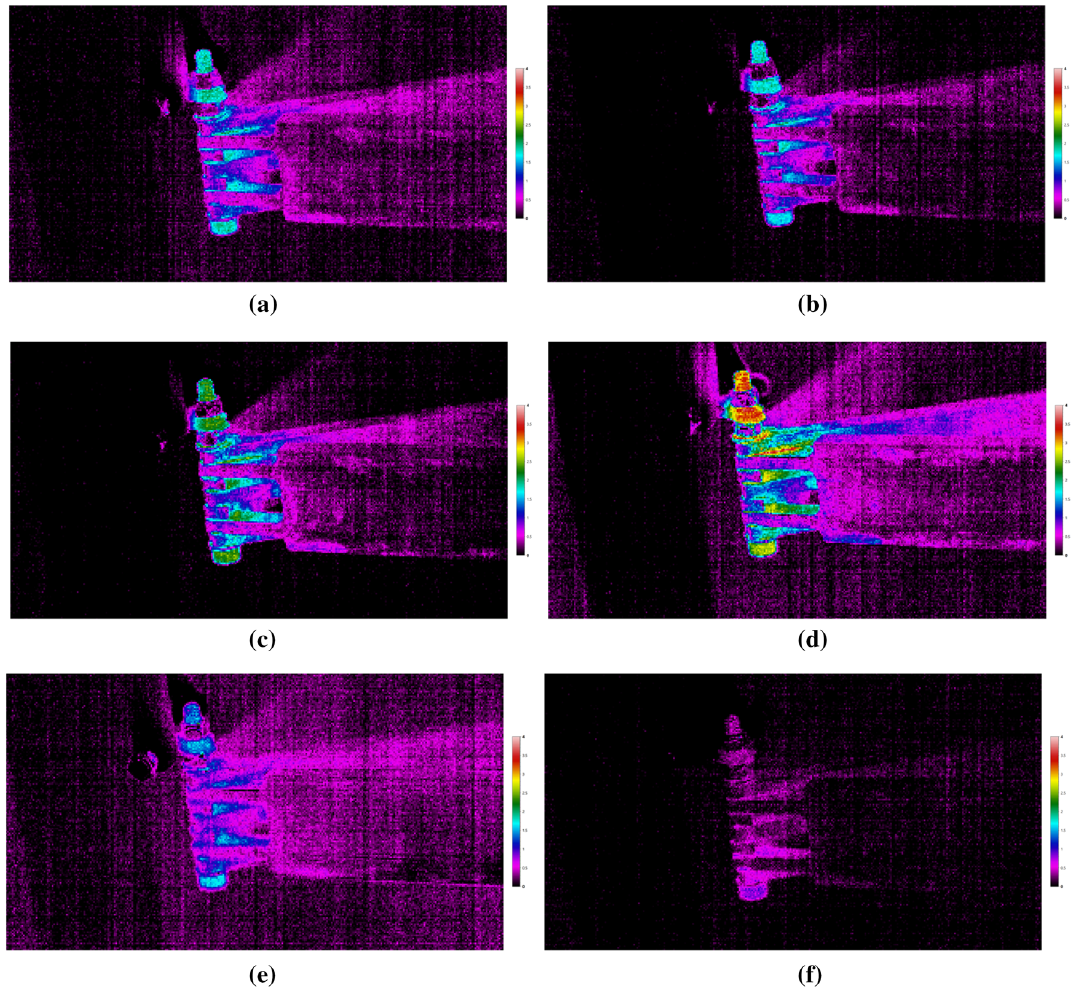
Fig. 18 The second snapshots from the six tests, sorted in descending order by bolt load ((a)-(f) 6.0 Nm, 4.5 Nm, 3.0 Nm, 1.5 Nm, 0.5 Nm and 0 Nm)